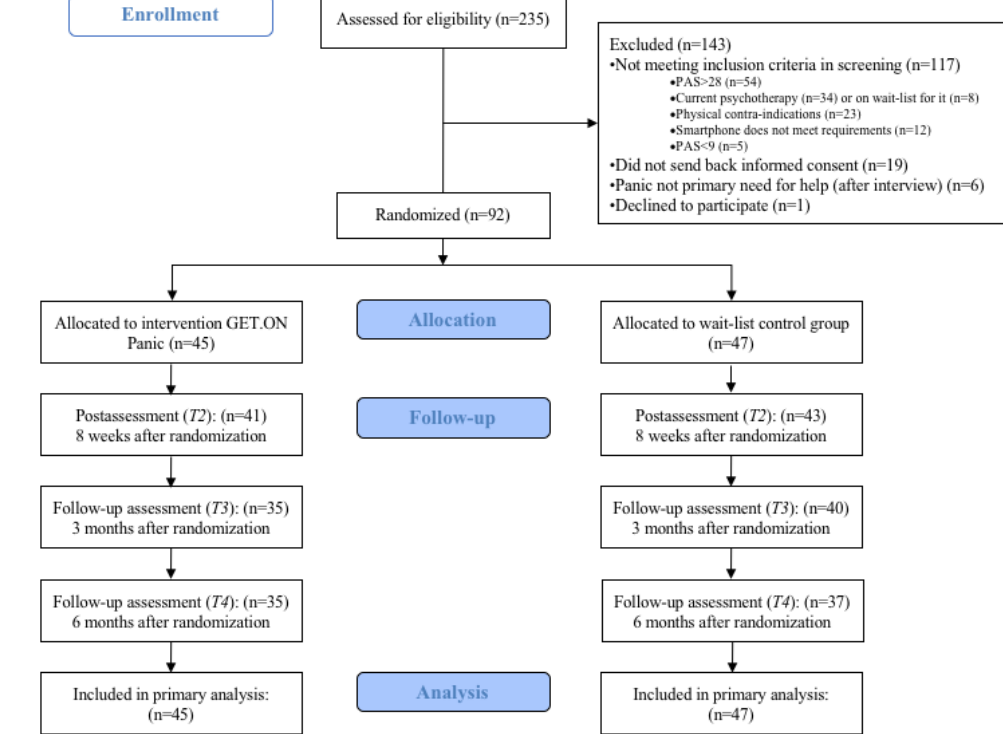
Figure 1. Study flow. PAS: Panic and Agoraphobia